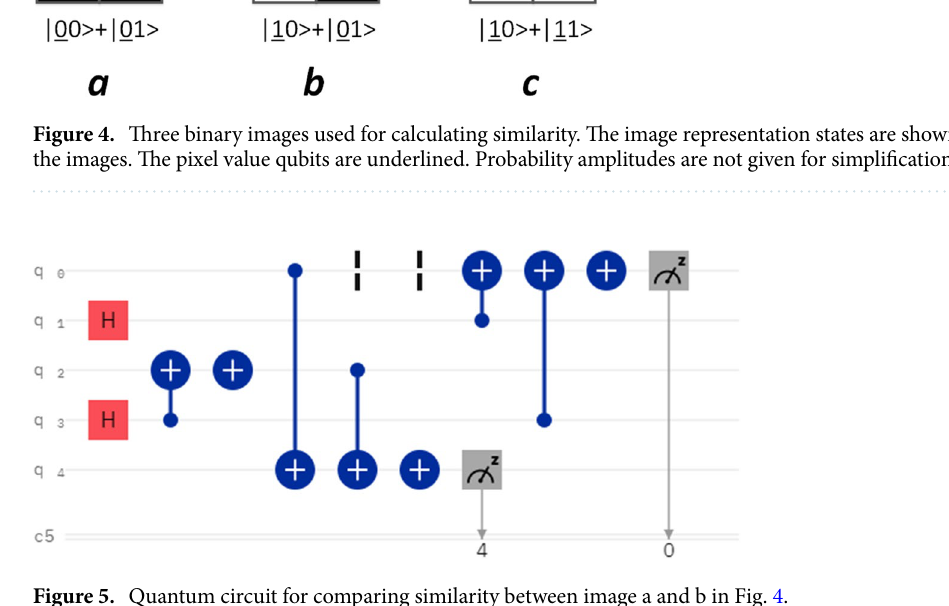
Figure 5. Quantum circuit for comparing similarity between image a and b in Fig.